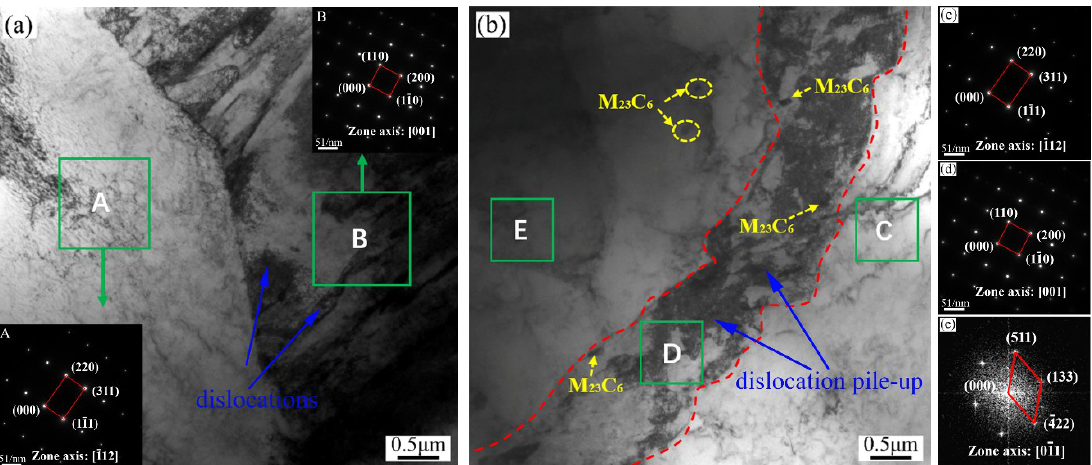
Figure 4. Brightfield transmission electron micrographs (TEMs) at the joint or Ni/steel interface and corresponding fast fourier transform (FFT) diagram: ( a ) prior to tempering treatment and ( b ) subject to tempering treatment. ( c , d ) show the selected-area diffraction pattern (SADP) of fixed area marked with green rectangles, ( e ) SADP of the M 23 C 6 indicated by the arrow in b.